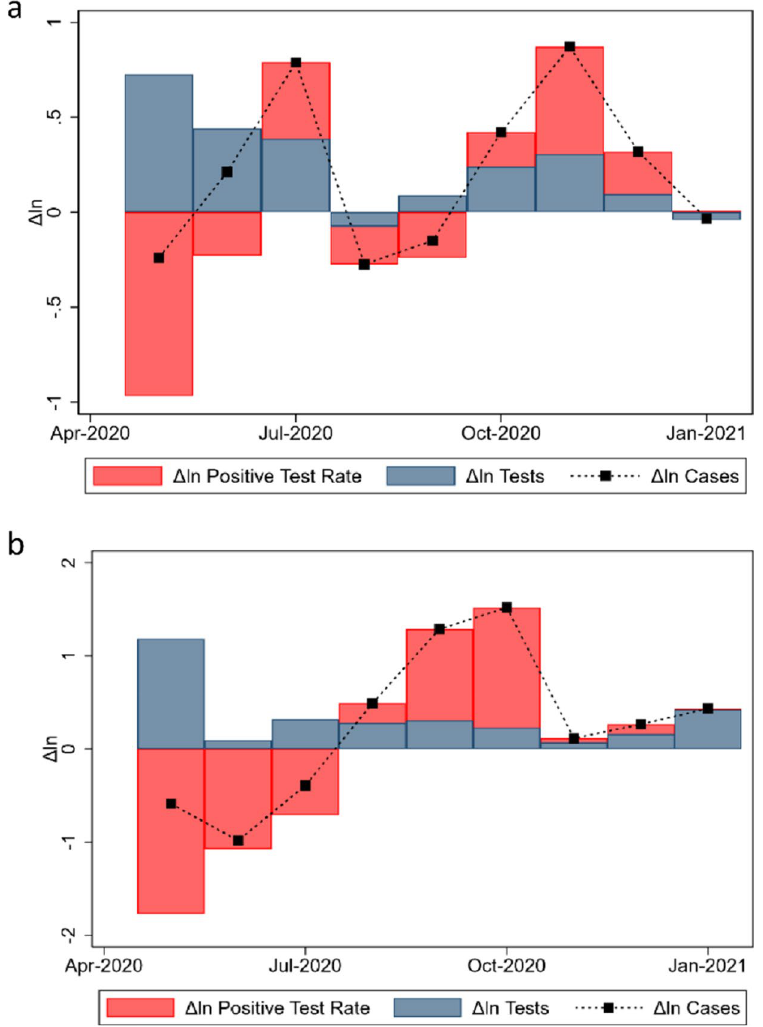
Figure 3. Exact decomposition of cases in the United States ( a ) and the United Kingdom ( b